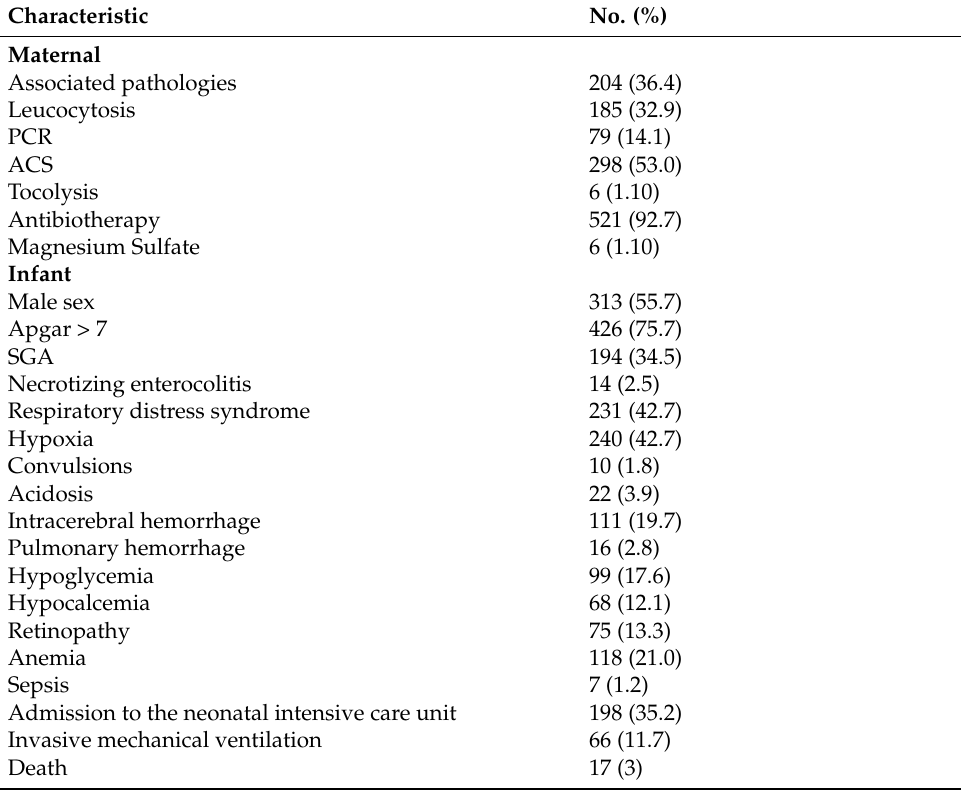
Table 3. The incidents of the main maternal and neonate analyzed